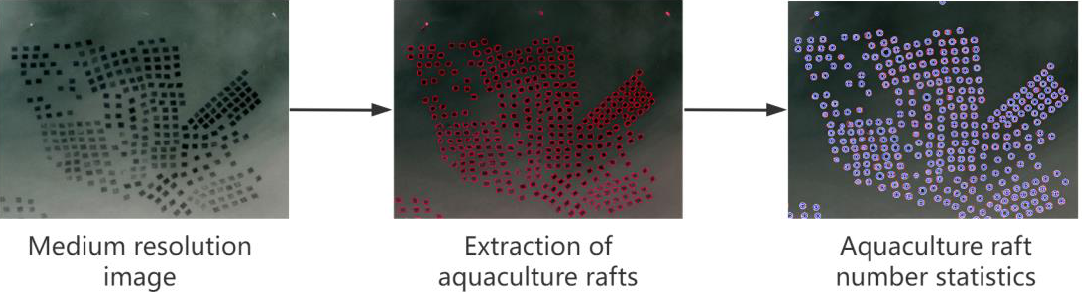
Figure 4. Schematic diagram of the automatic statistics of the aquaculture rafts.